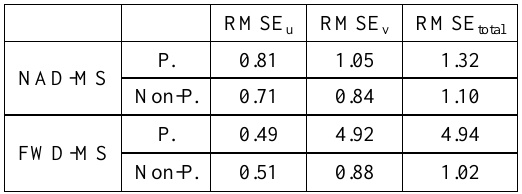
Table 2. The RMSE (in pixel) of deformation predicted by parameterized (P.) and non-parameterized (Non-P.) methods on the two co-registration experiments. In this case of ZY-3 images, u is deformation across the flight direction while v is deformation along the flight direction. The circular accuracy of the vector (u, v) is implied by RMSEtotal. The result of our non-parameterized method is produced with an experimentally designed setting: α 0 = 800, α e = 1,500, γ = 2, β = 1, η 0 = 6 and η 1 = 6. We also use the ENVI 4.8 software to produce the result of the compared conventional parameterized method. Specifically feature points are extracted with